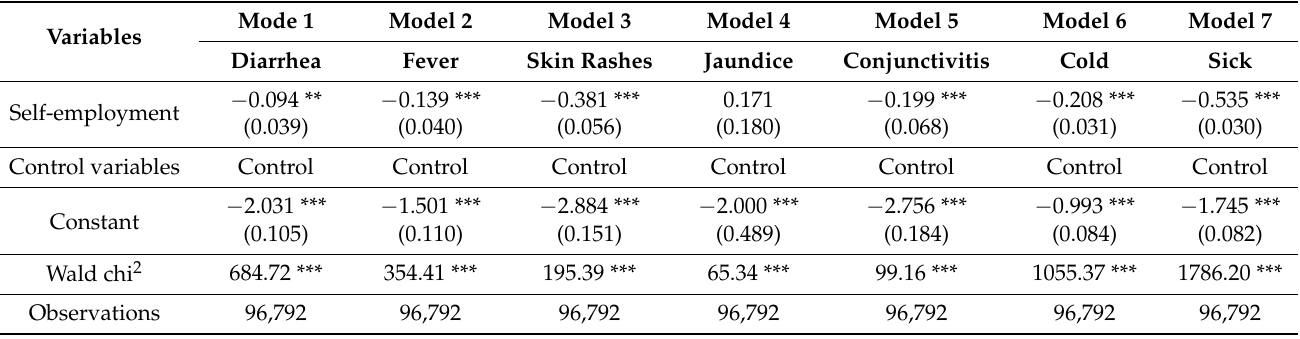
Table 5. Robustness test